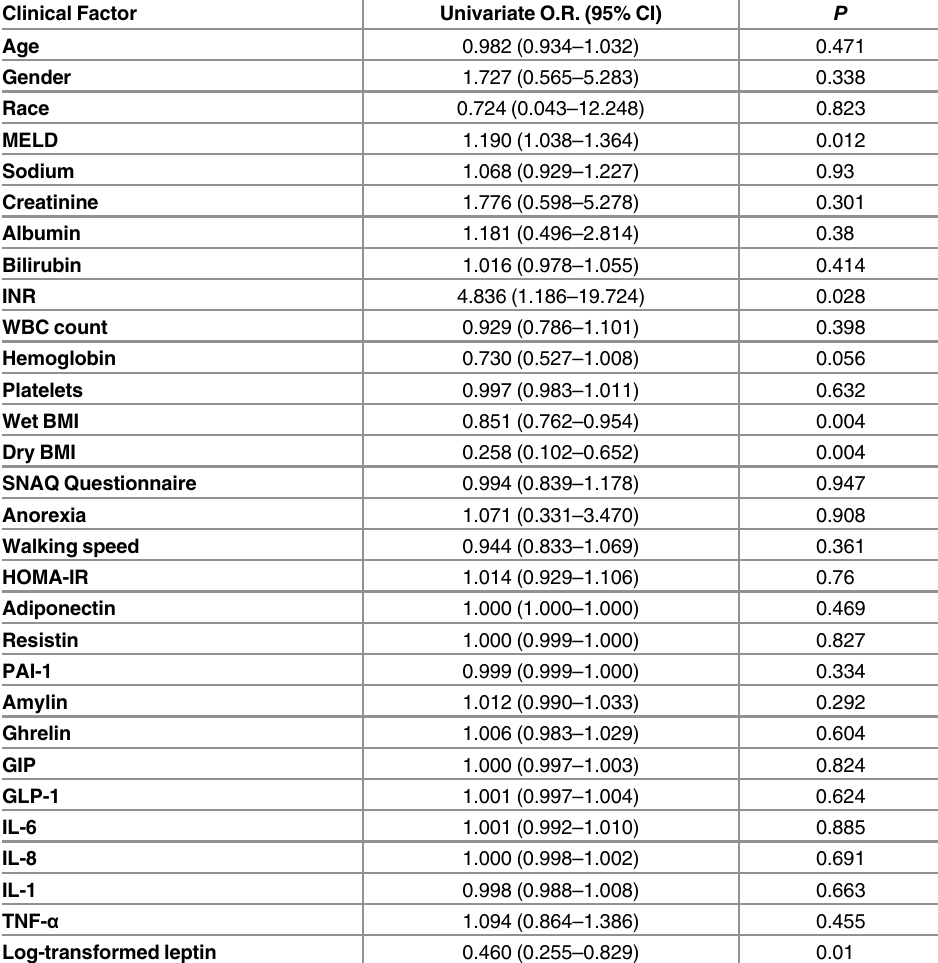
Table 3. Univariate logistic regression analysis for factors associated with malnutrition. Clinical